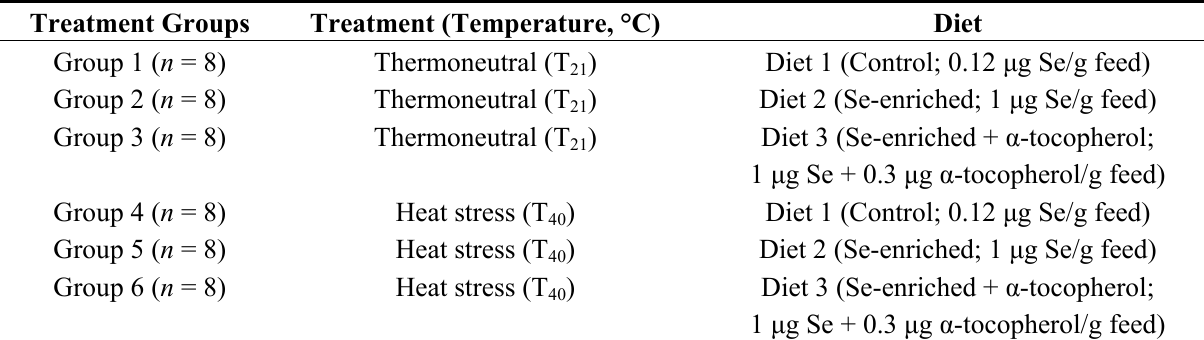
Table 1. Rat treatment